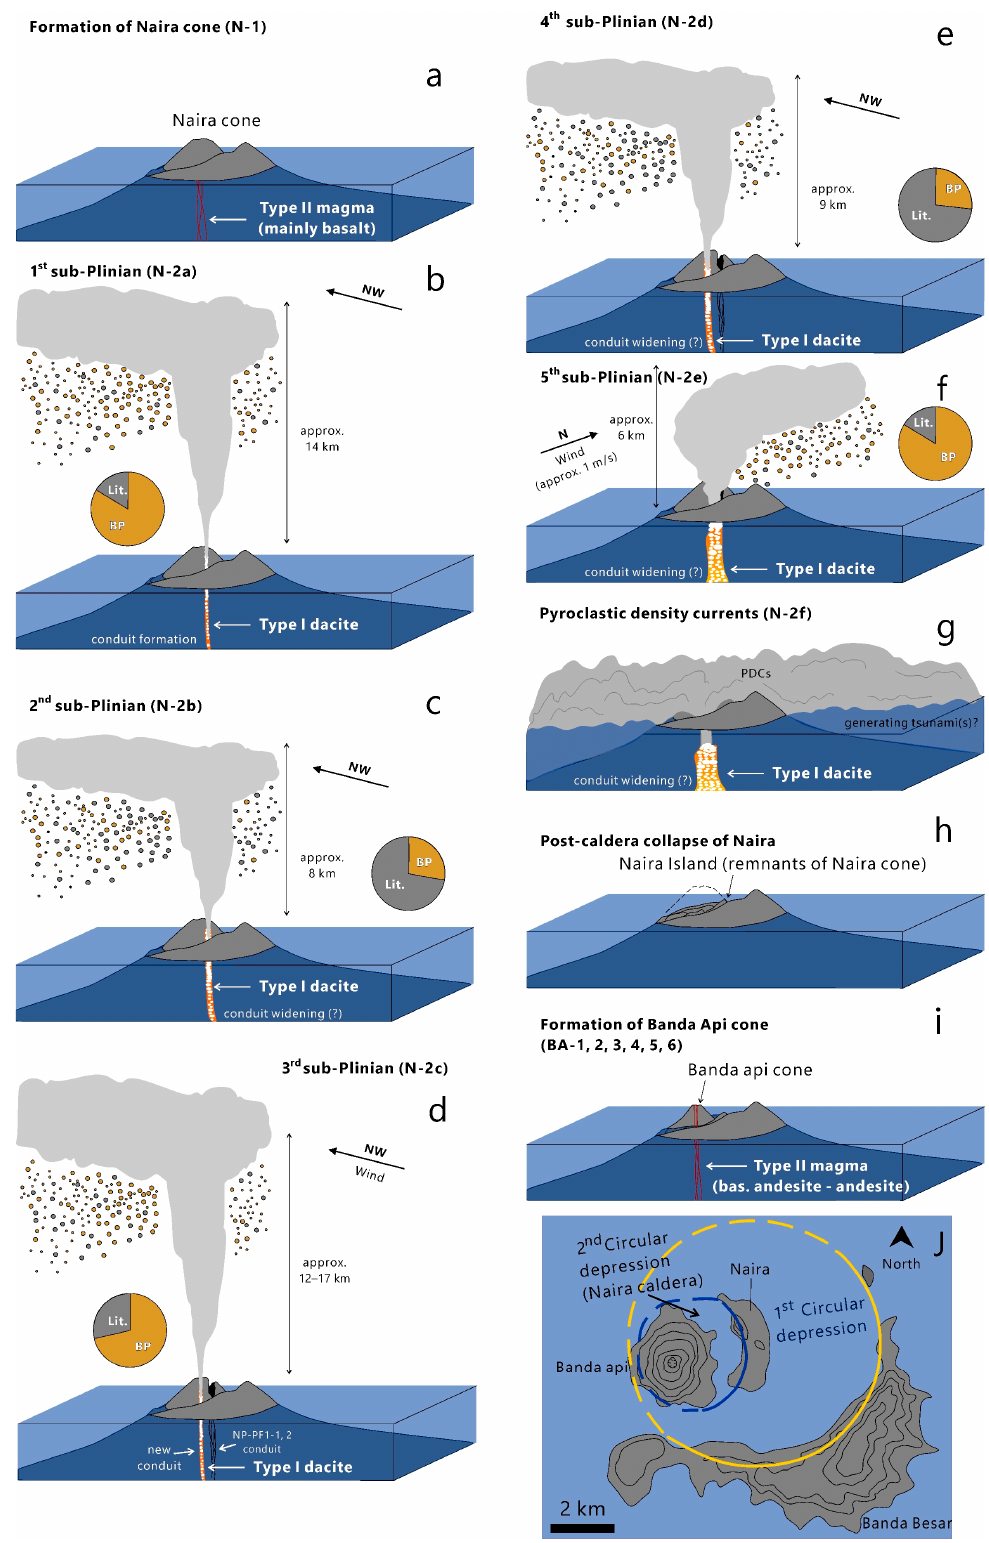
Figure 15. Formation of the Naira caldera. Pie charts are componentry results, with brown and dark grey colors representing brown pumice and lithics, respectively. Wind direction (as shown by the black arrow) is obtained from the direction of isopach (see also Figure 9). ( a ) The extrusion of type II magma (N-1) constructed the Naira cone. ( b ) The second caldera episode was initiated by